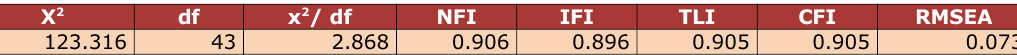
Table 5. The fitting degree index of structure confirmatory factor analysis of 3